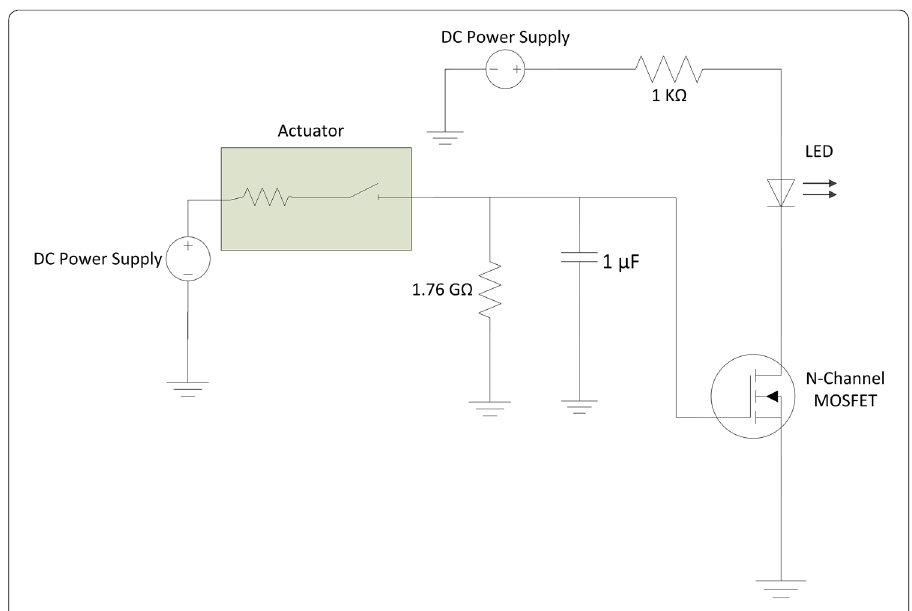
Fig. 6 Pull‑in detection